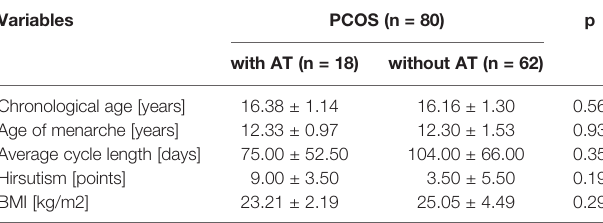
TABLE 1 | Clinical characteristics of patients with PCOS: with AT and without AT. Variables